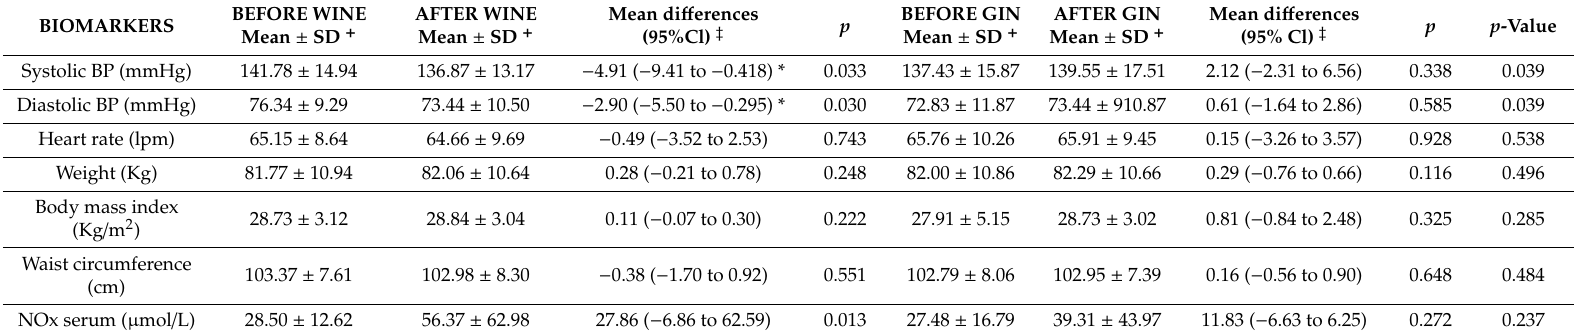
Table 4. Mean biomarker values before and after the 3-week aged white wine and gin